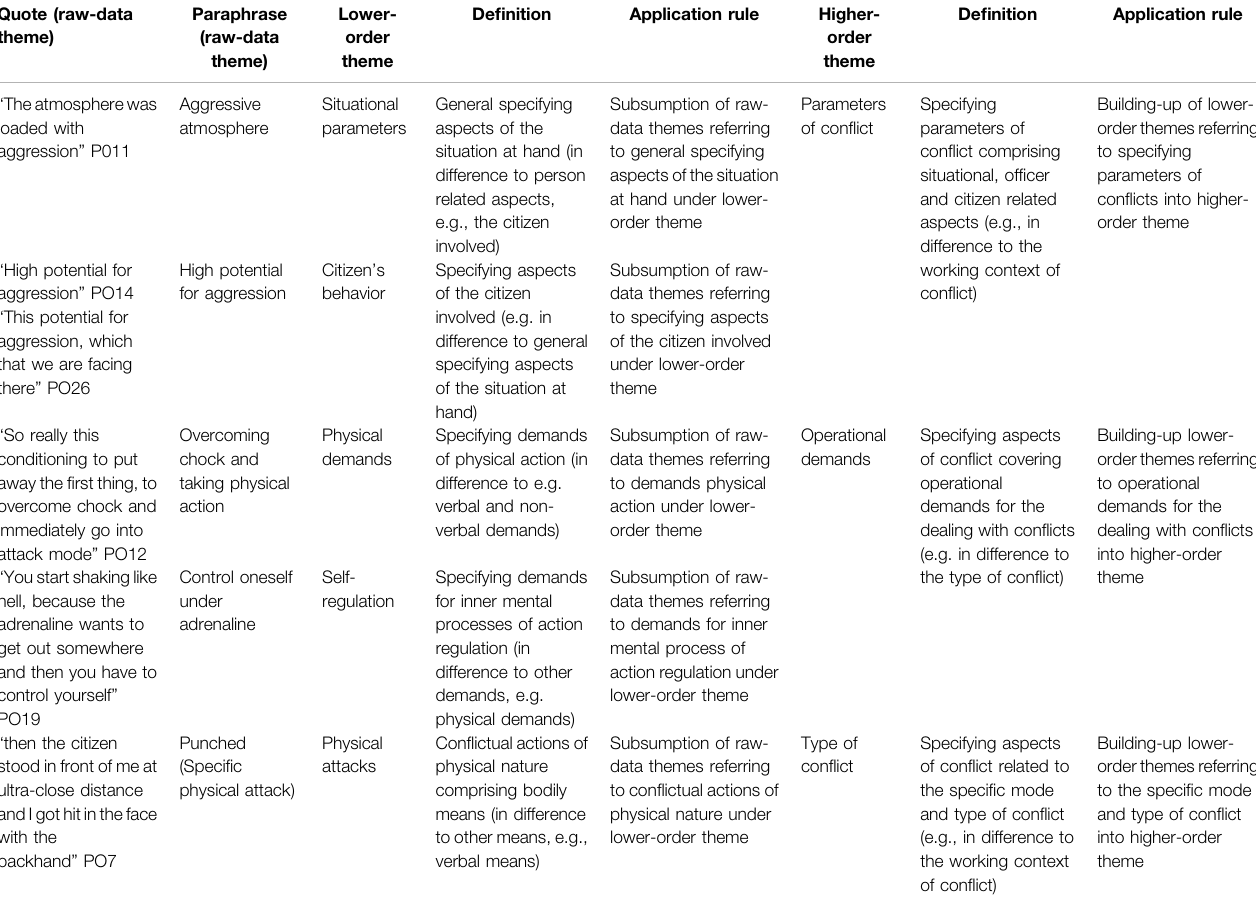
TABLE 1 | Coding examples of building up process of raw-data, lower-order themes and higher-order themes. Quote (raw-data